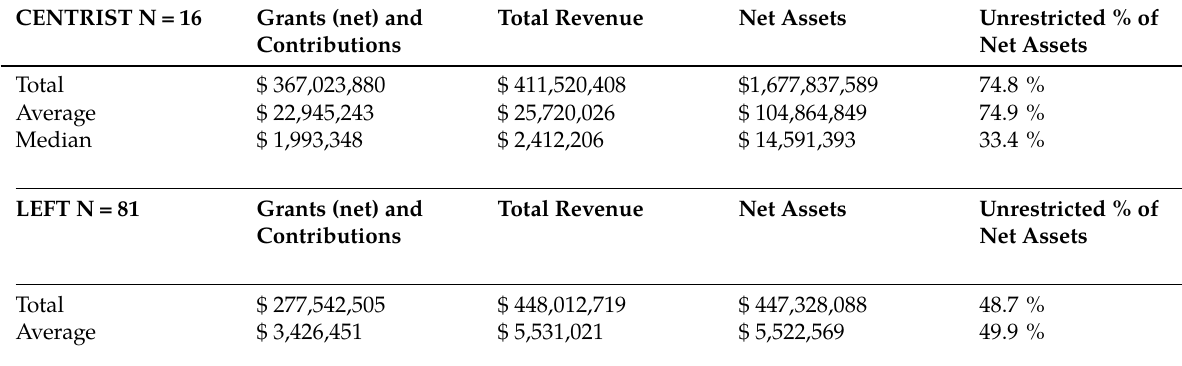
Table 3: Total, average, and median think tank revenues and assets,